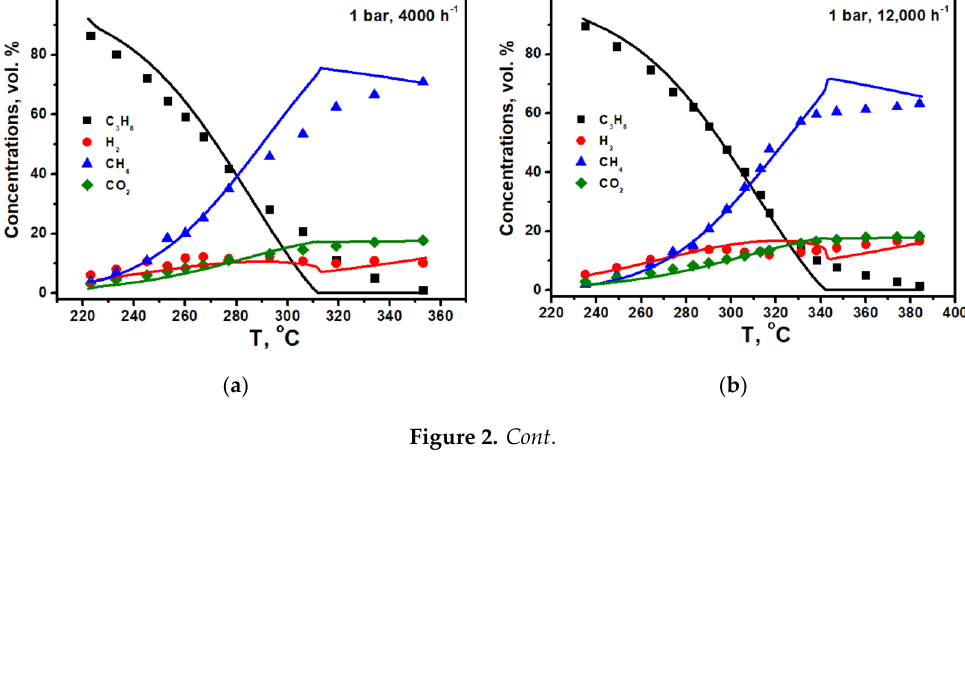
E E k k ref , met , ref , met and n obtained by solving the inverse